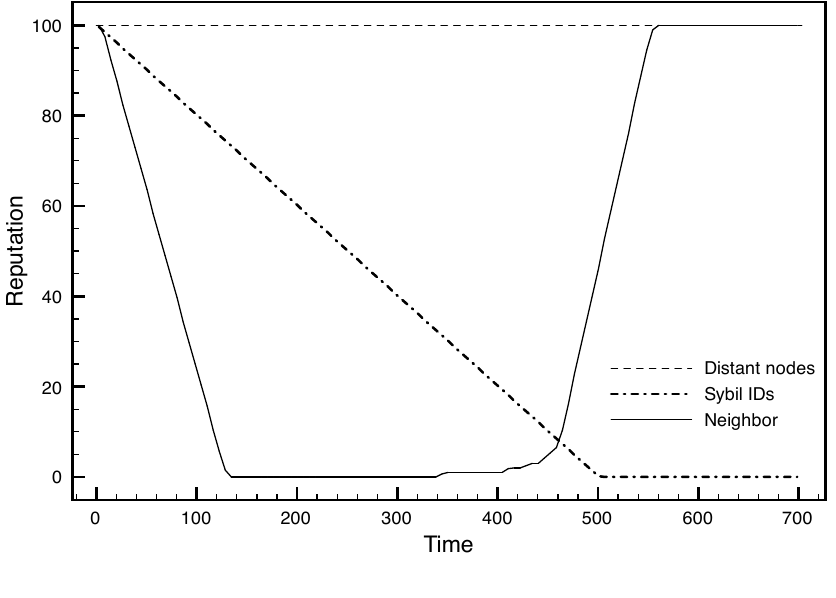
Figure 4. Reputation evolution for three different nodes during a sybil attack (the attacked node, a neighbor, and a distant